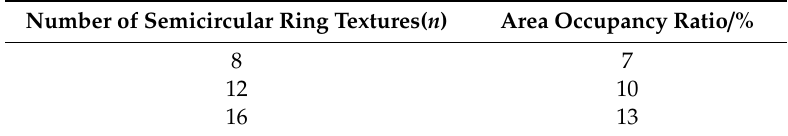
Table 6. Correspondence between the number of semicircular ring micro-textures and the area occupancy ratios of texture arrays.